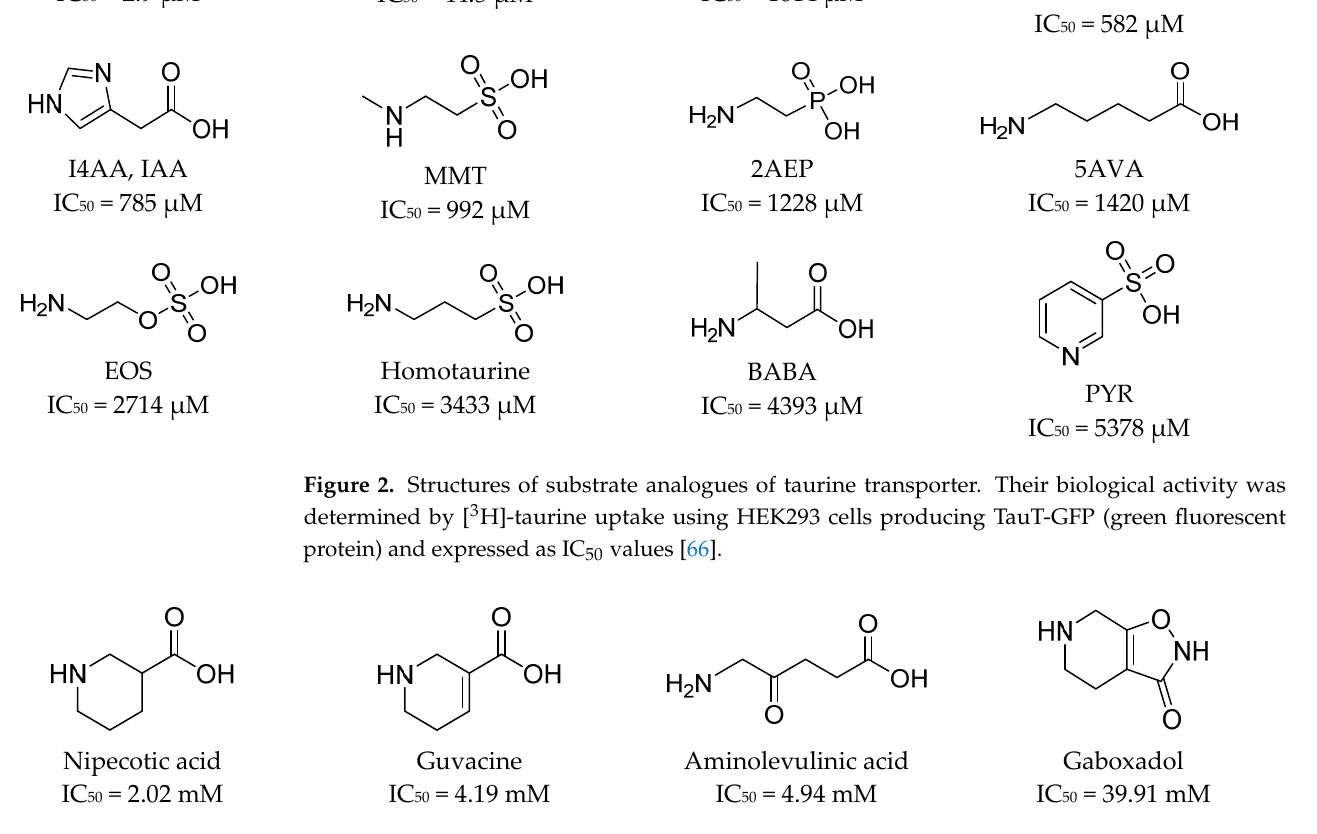
Figure 2. Structures of substrate analogues of taurine transporter. Their biological activity was determined by [ 3 H]-taurine uptake using HEK293 cells producing TauT-GFP (green fluorescent protein) and expressed as IC 50 values [66].